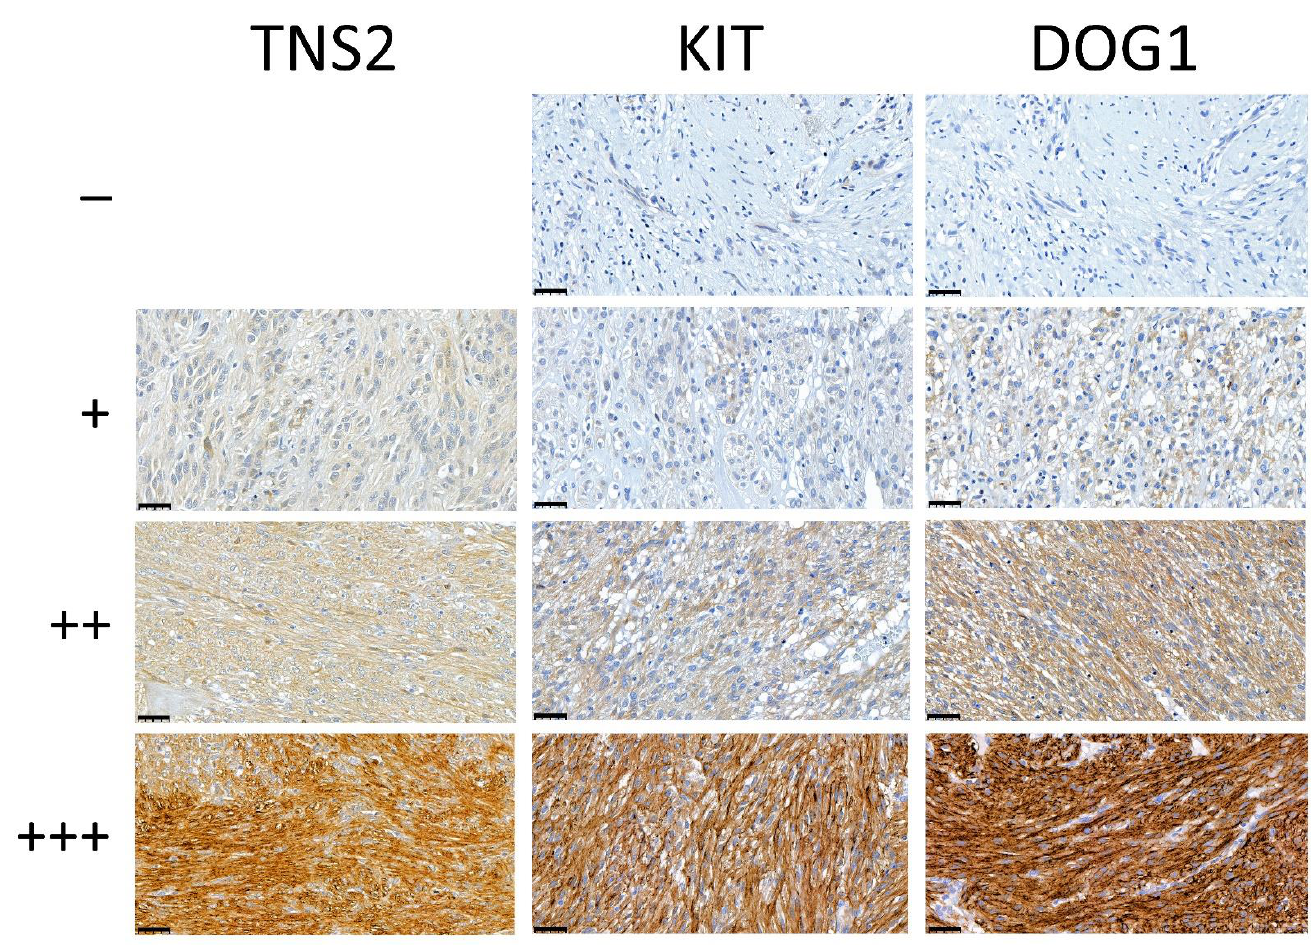
8 of 19 Figure 1. Relative expression of TNS2 among different selected healthy (green) and cancerous (red) tissues. Expression in GIST is highlighted in blue. Numbers of cases are given in parentheses and individual outlier samples are shown as hollow circles. Data are modified from the IST database,